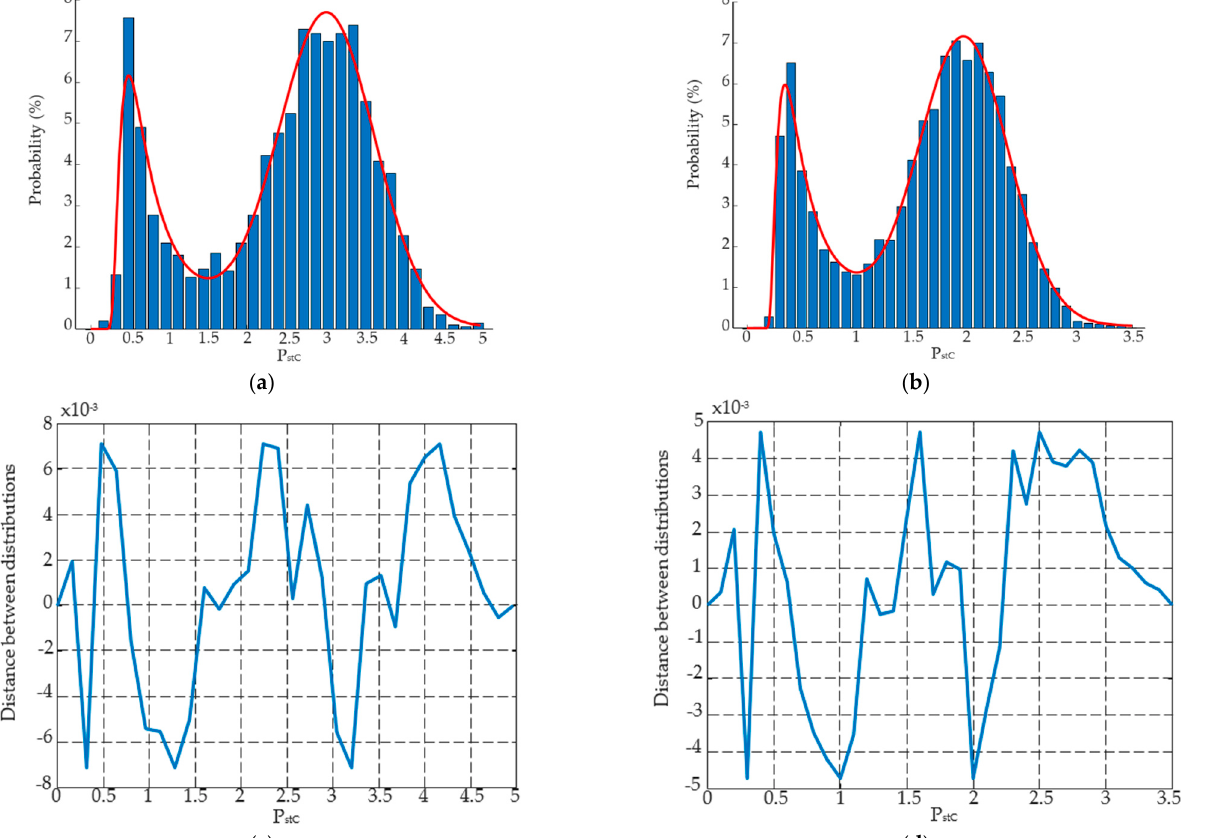
Figure 10. Histograms of two furnace conditions ( a , b ) and graphs of differences in distribution functions of the measured